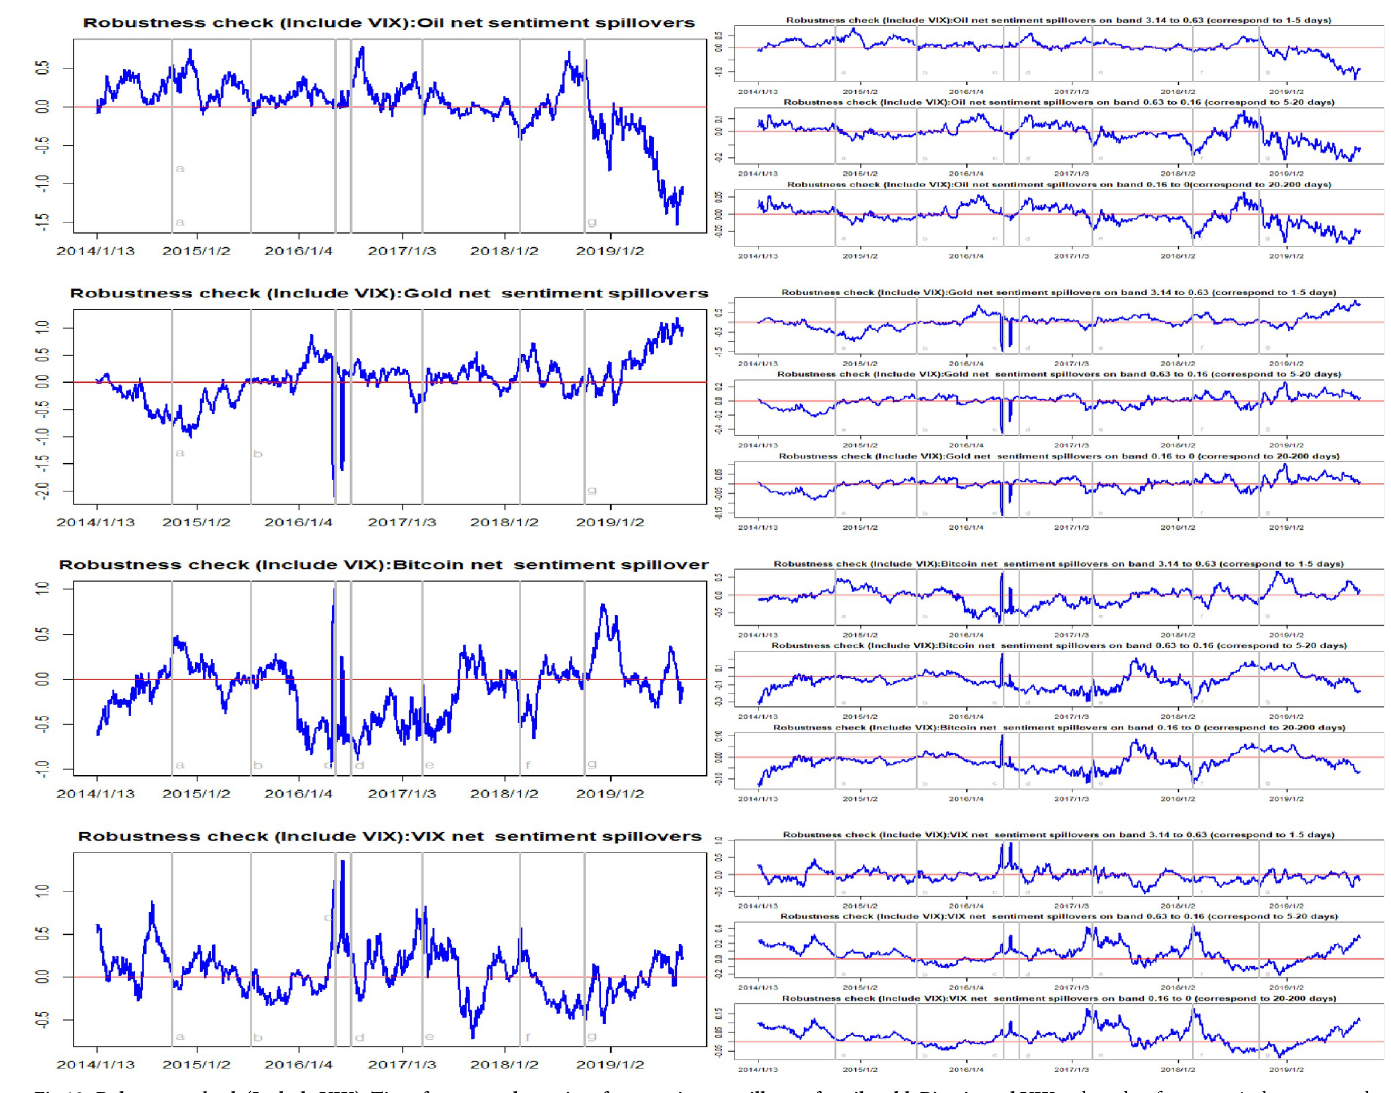
Fig 12. Robustness check (Include VIX): Time-frequency dynamics of net sentiment spillovers for oil, gold, Bitcoin and VIX. a, b, c, d, e, f, g respectively represent the seven events: the WTI oil price collapsed in October 2014, the black swan event in gold market occurred in July 2015, the sharp rise of Bitcoin prices in May 2016, the Brexit event in July 2016, the expectations of a Federal Reserve rate hike in March 2017, the price of Bitcoin and gold fluctuating fall at the beginning of 2018, and the WTI oil price declines in August 2018.